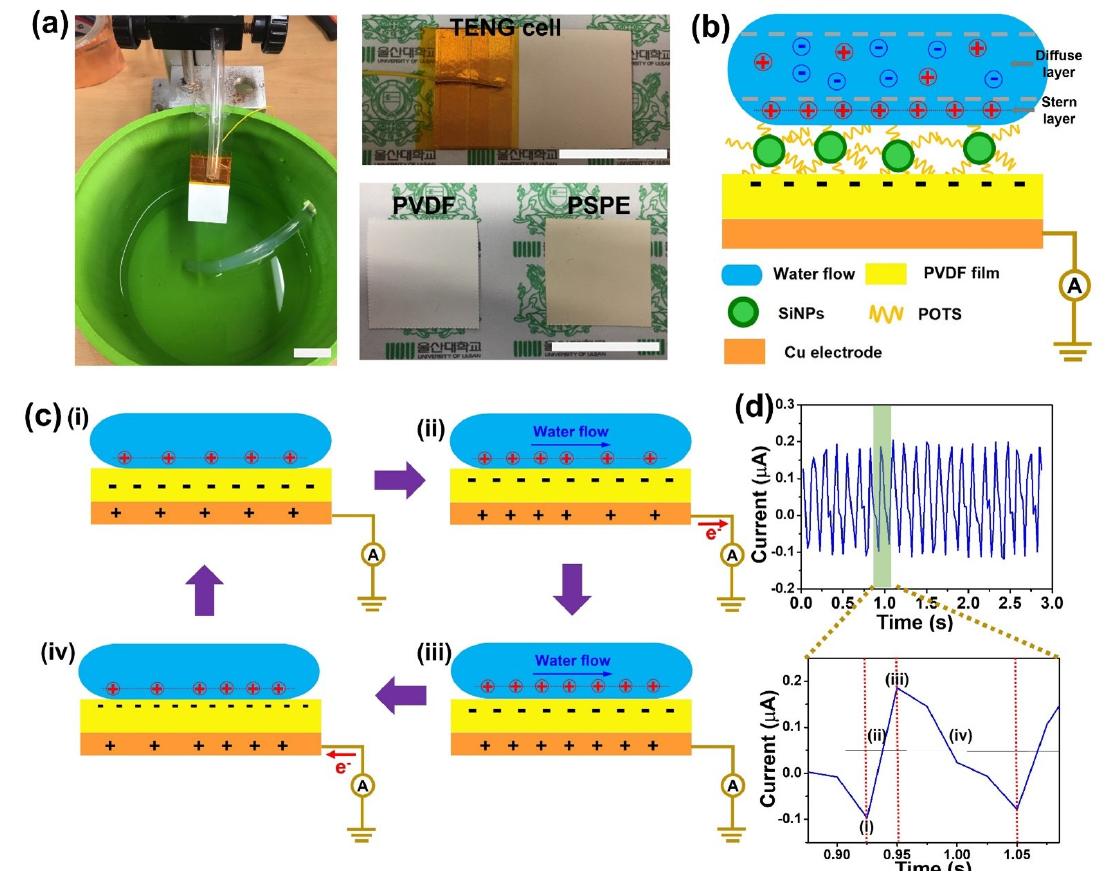
Figure 4. ( a ) The photograph of the TENG system on the left side; the TENG device, PVDF and PSFE film on the right side (scale bars of 2 cm); ( b ) schematic diagram of the TENG structure in contact with water flow; ( c - i – iv ) the working principle of the TENG; ( d ) Output current of the TENG and magnified view of a cycle showing four states in working